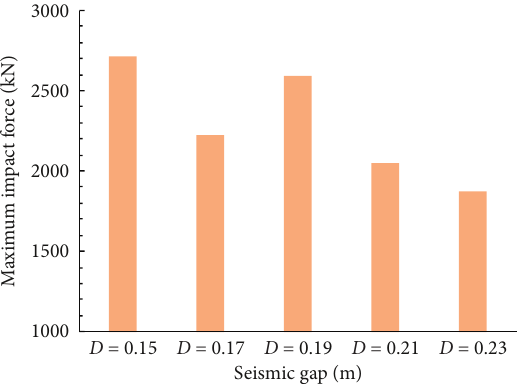
Figure 14: Influence of gap size on impact force (PGA � 0.62g).